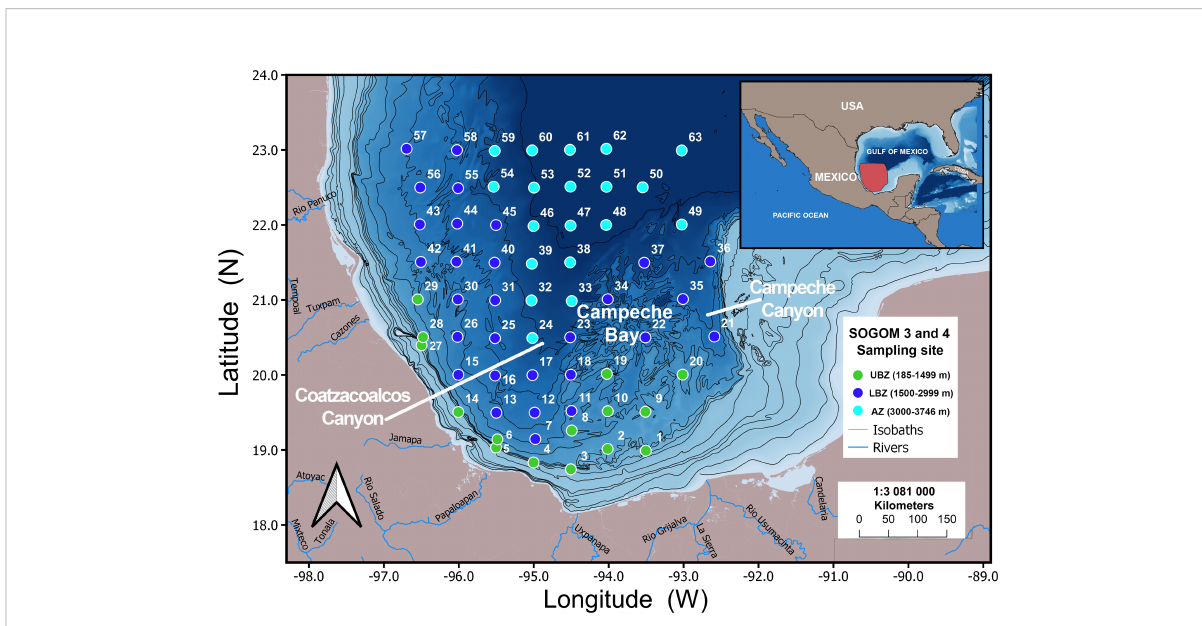
FIGURE 1 Location of the 63 sites sampled during the oceanographic cruises SOGOM 3 and SOGOM